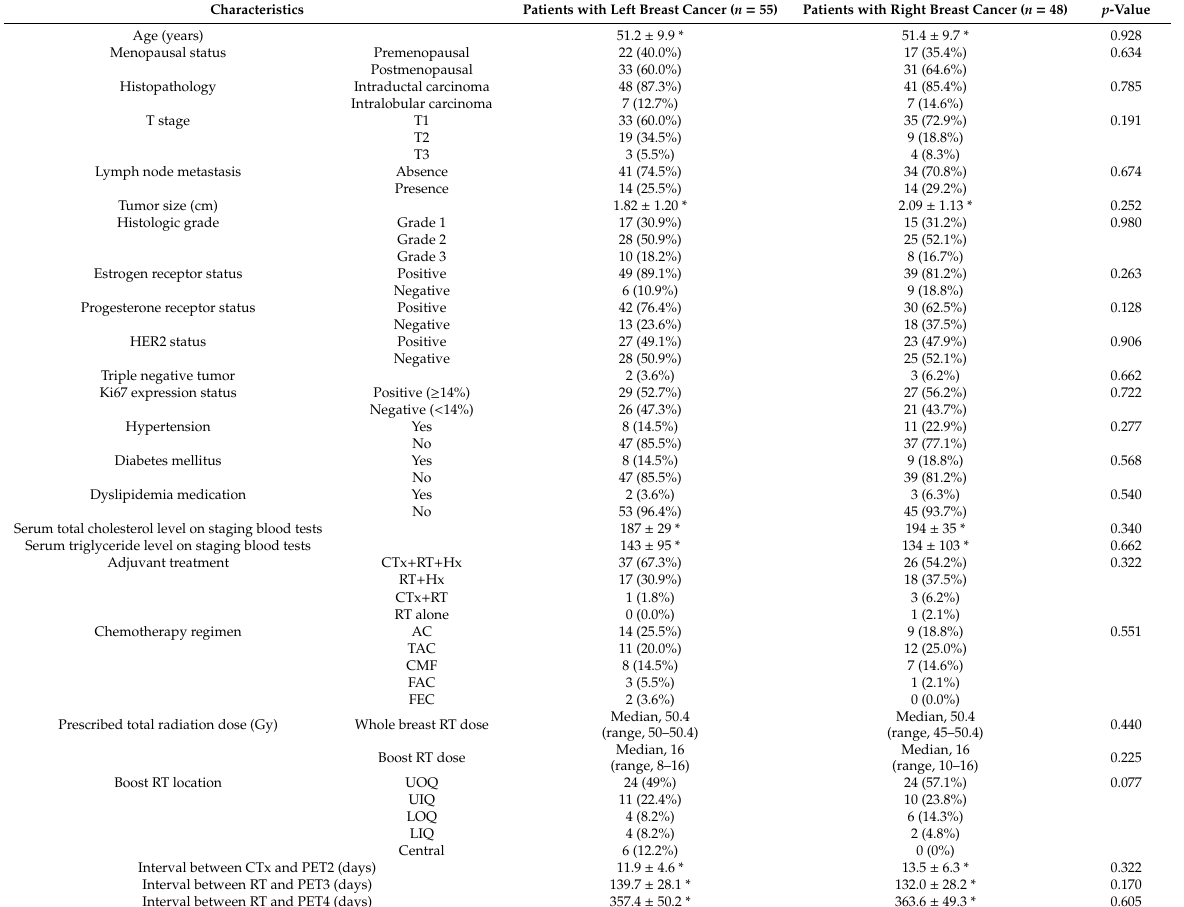
Table 1. Characteristics of the enrolled